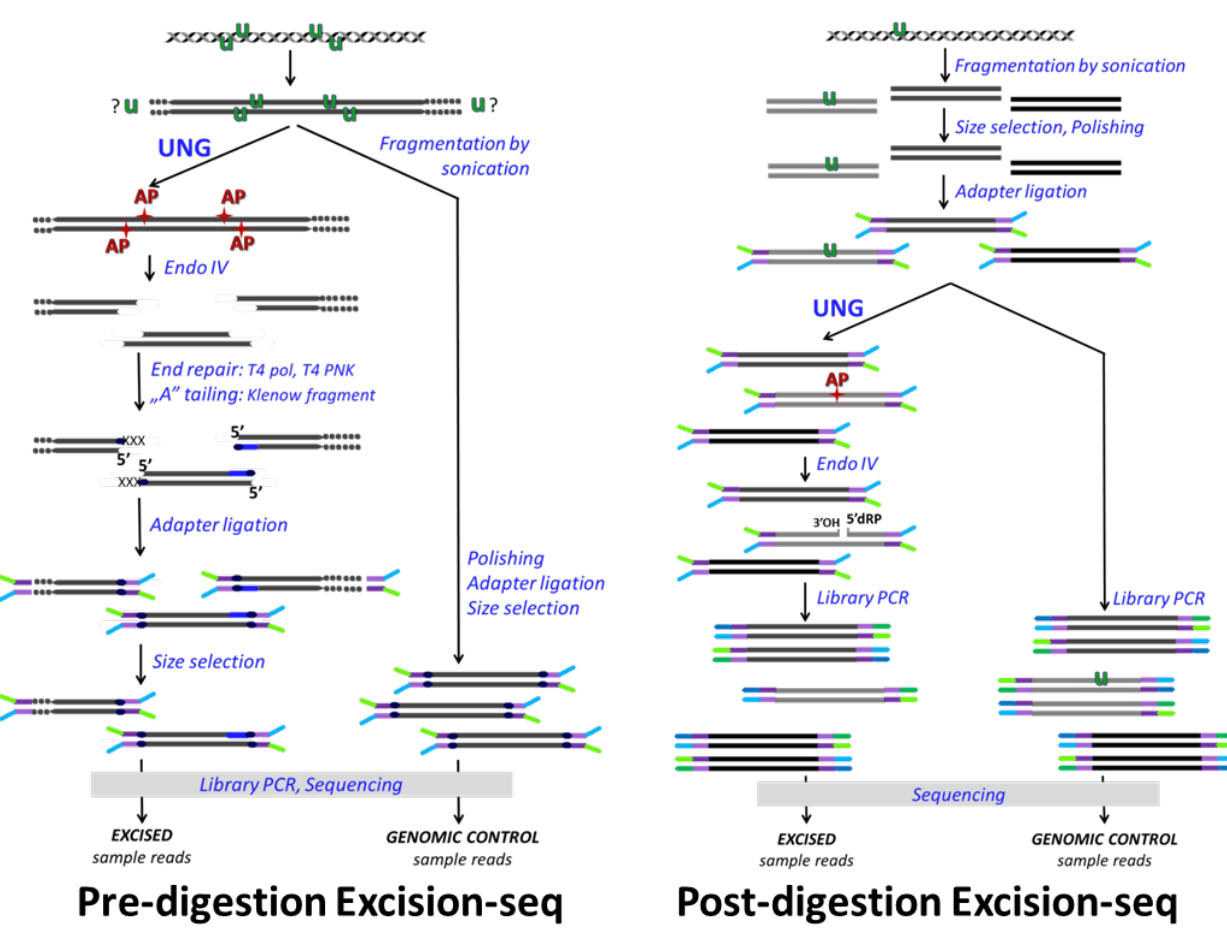
Figure 3. Excision-seq for genome-wide mapping of U-DNA. ( a ) Pre-digestion Excision-seq. For efficient detection, high density of genomic uracils (green U) is required, because NGS-compatible fragments originate from the UNG/ENDO IV treatment. Longer fragments (indicated with dots at the end) are lost during the size selection. End repair involves T4 polymerase (T4 pol), T4 polynucleotide kinase (T4 PNK), and Klenow fragments. Both ends of the sequencing reads report on uracil sites, but some uracils might escape detection. Non-specific hits are filtered by the comparison to genomic control sequencing. ( b ) Post-digestion Excision-seq. Genomic fragments are treated with UNG/ENDO IV, and degradation of uracil-containing fragments results in locally decreased read coverage as compared to the sequencing of the non-treated genomic fragments.